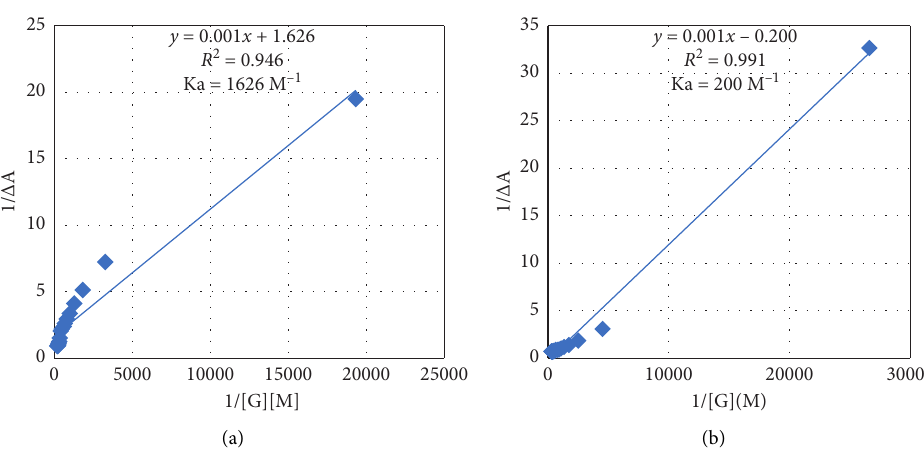
Figure 1: Association constant results for (a) MMA and DZM; (b) AAM and DZM.